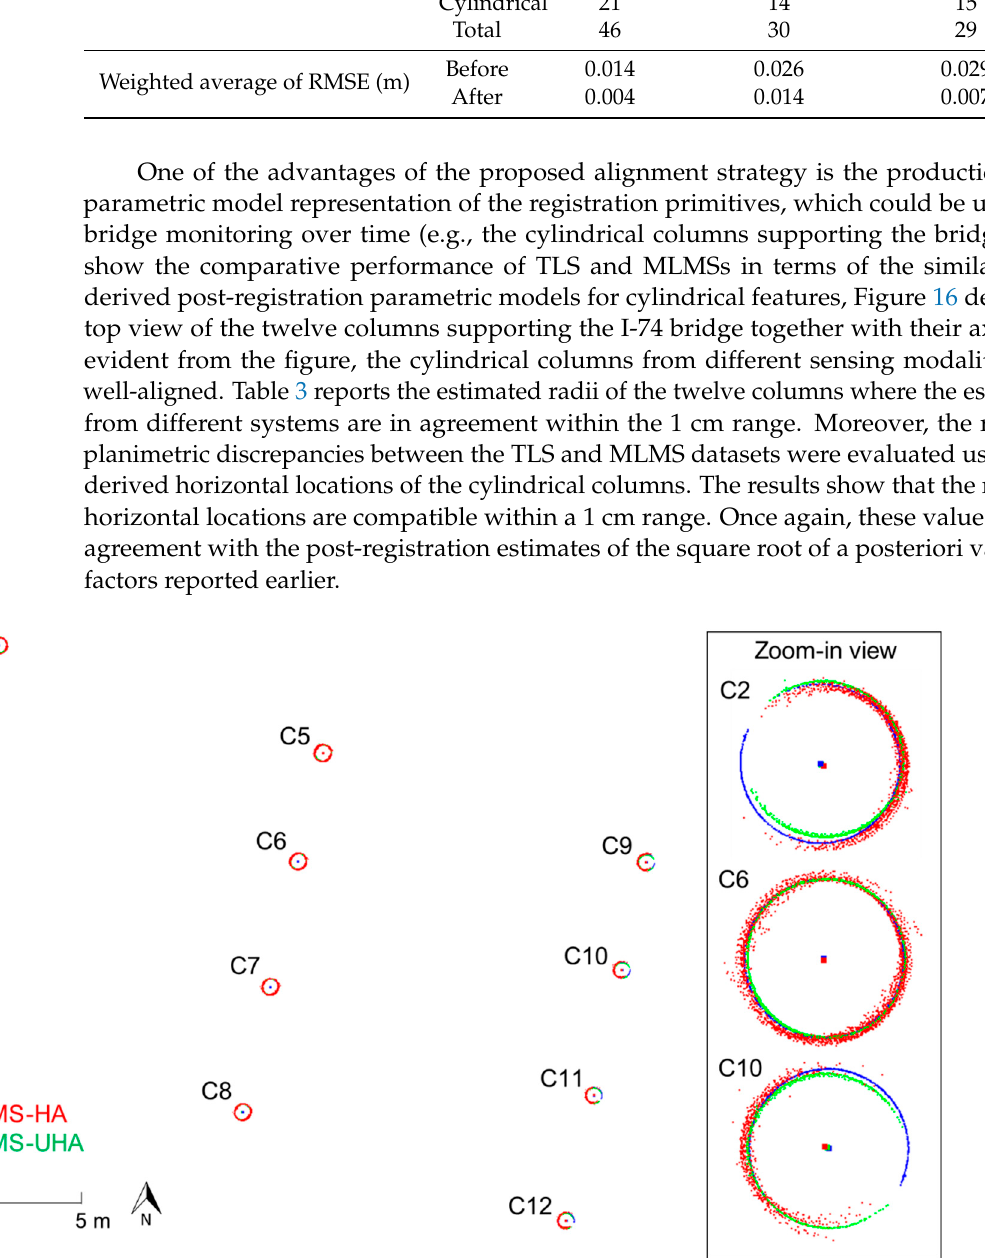
Figure 16. The twelve cylindrical columns and their axes derived from TLS (in blue), PWMMS-HA (in red), and PWMMS- UHA (in green) data.